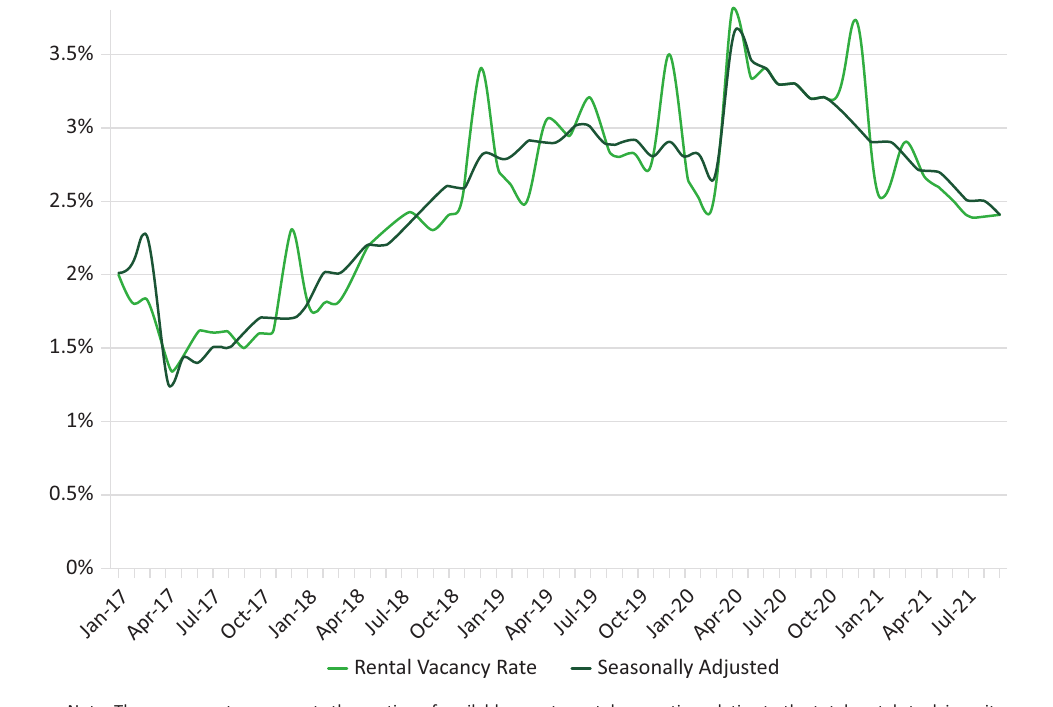
Figure 3. Residential rental vacancy rates (2017–2021). Source: Domain Research House (2021). rates, reaching 8.3% on average. However, differently from the impact on the residential market, the commer‐ cial vacancy rates did not correct in 2021 but continued to increase (Figure 4), reaching 8.5% in the first quarter